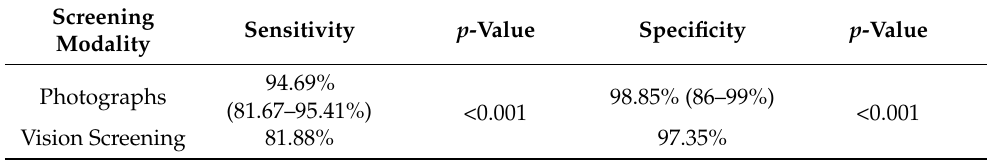
Table 6. Sensitivity and specificity of smartphone photographs vs. traditional vision